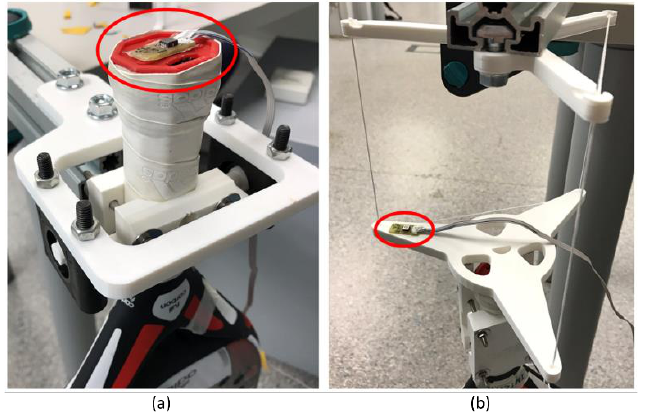
Figure 8. The location where the accelerometers are attached. ( a ) For horizontal pendulum and ( b ) for the vertical pendulum.